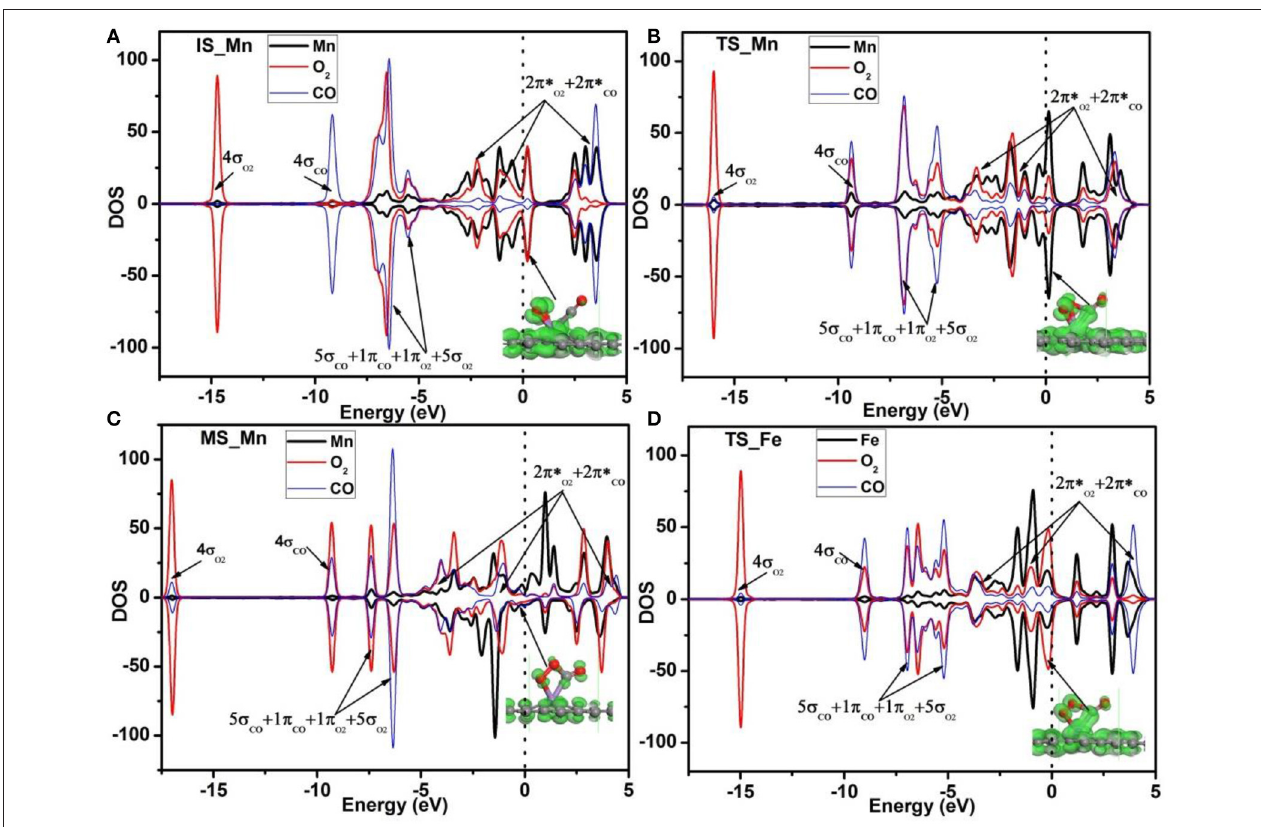
FIGURE 8 | PDOS of adsorbed O 2 , CO, and Mn atom on Mn-DG for the IS (A) , TS (B) , and MS (C) . PDOS of adsorbed O 2 , CO and Fe atom on Fe-DG for the TS state is also shown in (D) . Red, blue and black curves represent PDOS of adsorbed O 2 , CO, and Mn (or Fe) atom, respectively. The orbitals of the adsorbed O 2 and CO molecules are roughly labeled. Inset is the charge density of orbitals near the Fermi level. The vertical lines indicate the Fermi